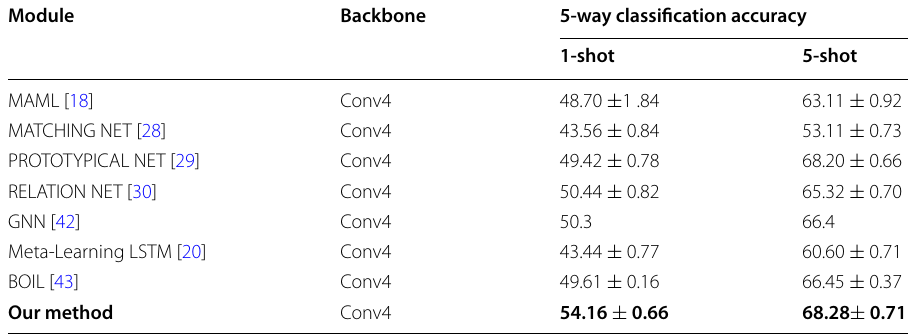
Table 3 Classification accuracy of few-shot image on the miniImageNet dataset (%)